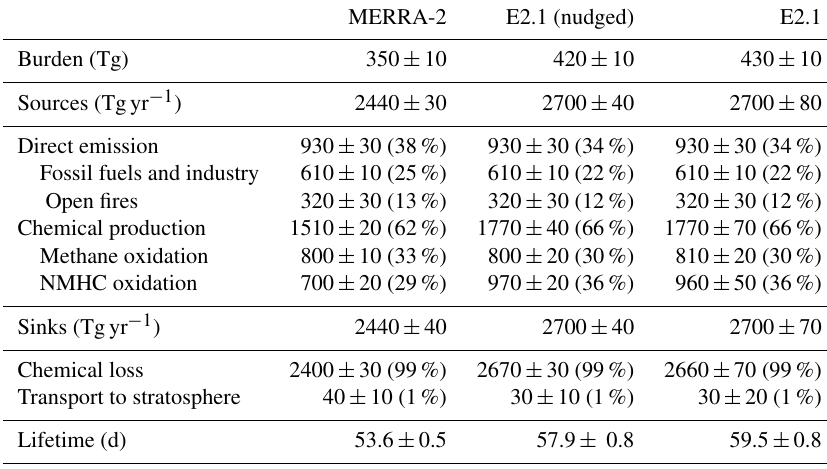
Table 8. Tropospheric carbon monoxide (CO) budget for 2005–2014CE.